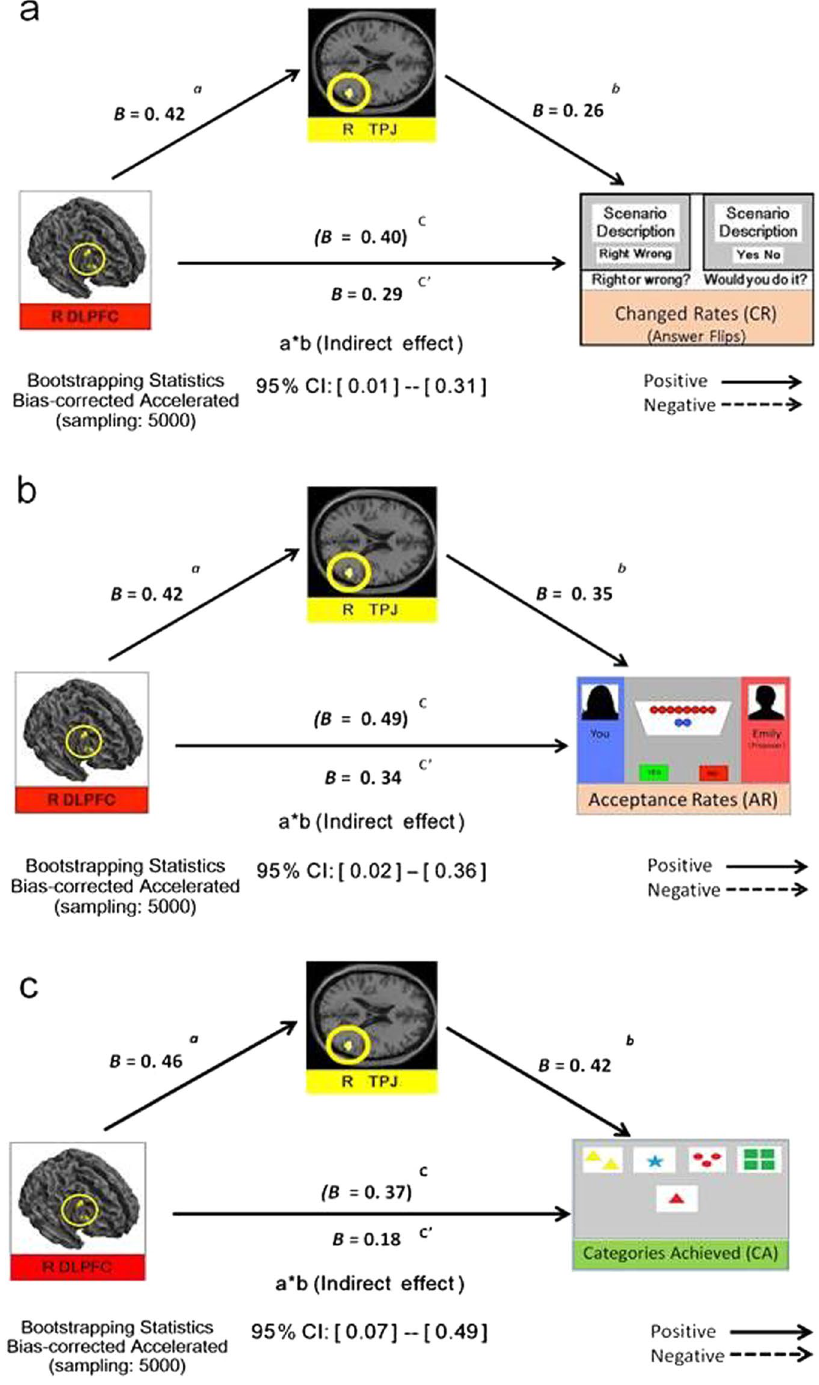
Figure 1. Mediation model for ( a ) moral, ( b ) economic, and ( c ) perceptual domains. R-TPJ was an effective mediator across all domains; there were significant indirect effects on the relationship between R-DLPFC and behavioural flexibility. ‘ B ’ denotes regression coefficients, indicating each link in the model. Confidence intervals (CIs) not including zero indicate indirect effects ( p <